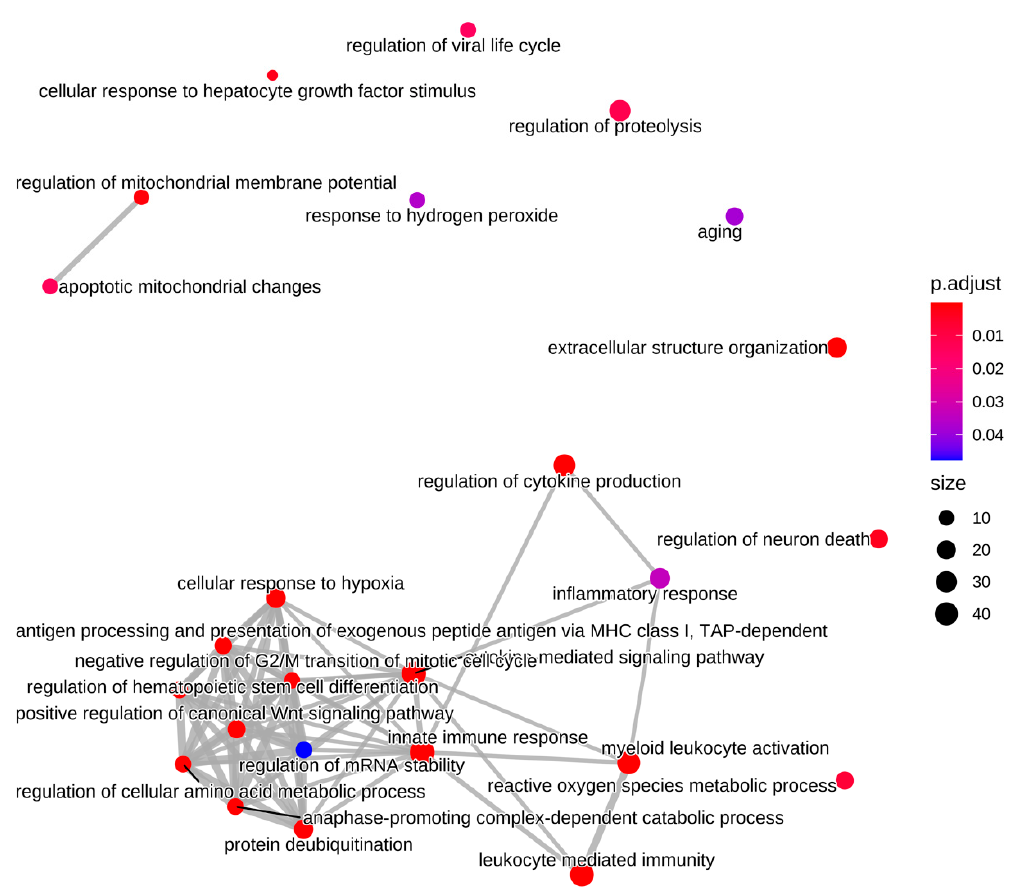
Figure 5. Enrichment map for GO biological processes. Up-regulated differentially expressed genes were enriched for biological processes including inflammation/immune response and reactive oxygen species/antioxidant responses. The size of the vertex indicates the number of DE target genes enriched for that term. The color of the vertex indicates the adjusted p -value and the edges (lines) connecting the vertices reflect DE target genes that were common between the GO terms.